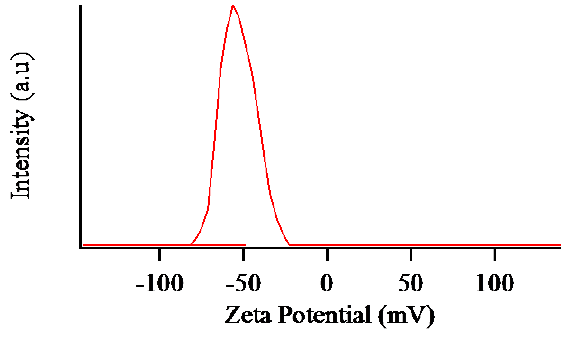
Figure 9. Zeta potential distribution graph of the MLG.